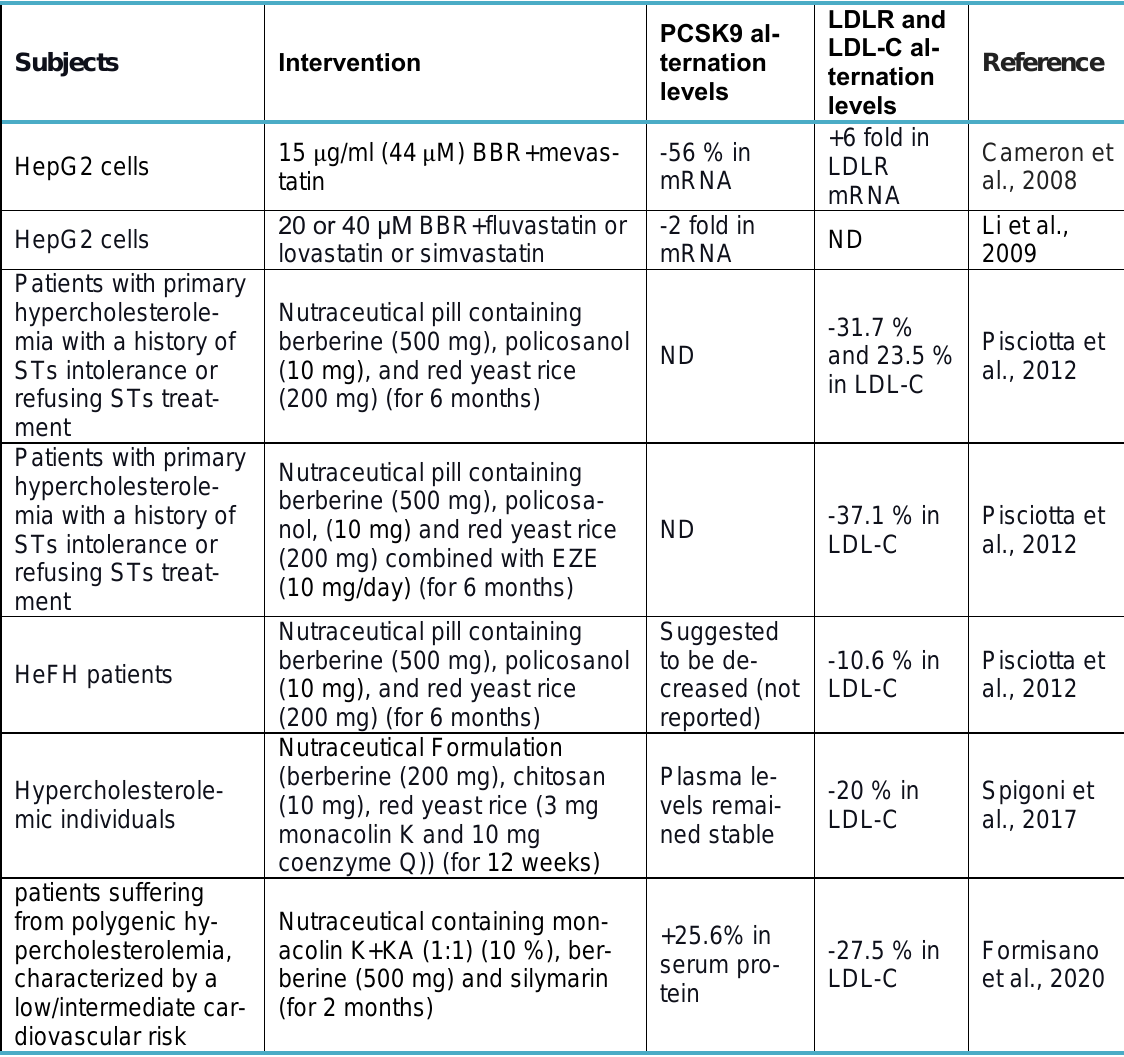
Table 2: Effect of berberine on PCSK9, LDLR, and LDL-C levels in combination with other nutraceuticals or medications in experimental studies